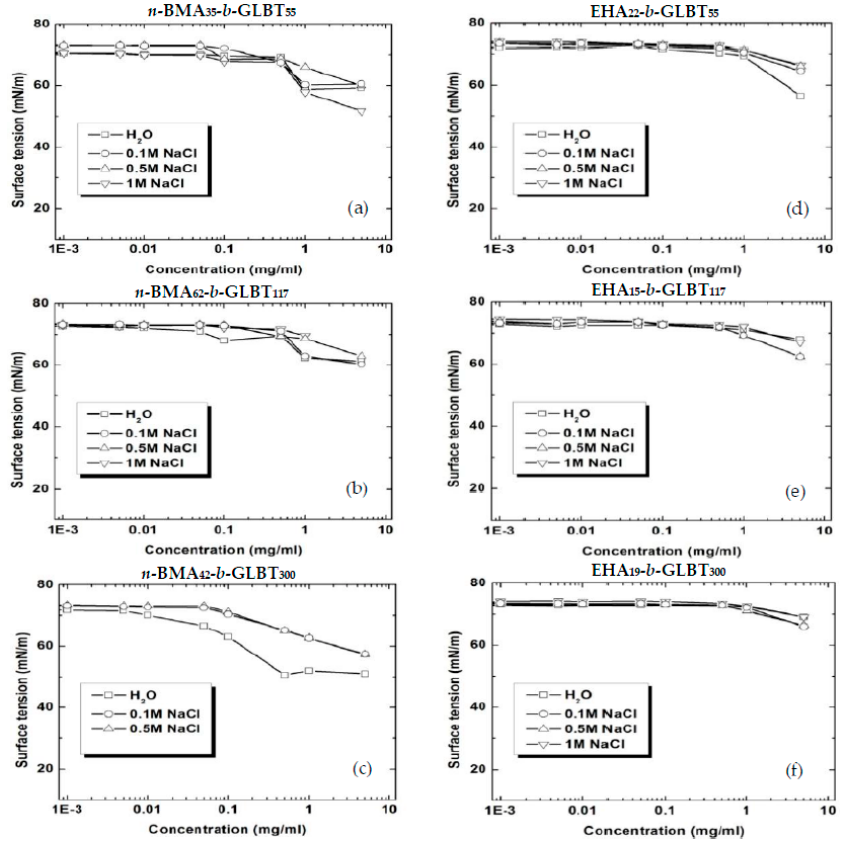
Figure 2. Comparison of the surface tension of ZABC’s having P( n -BMA) and PEHA as a function of their concentrations in water and various concentrations of sodium chloride solutions.